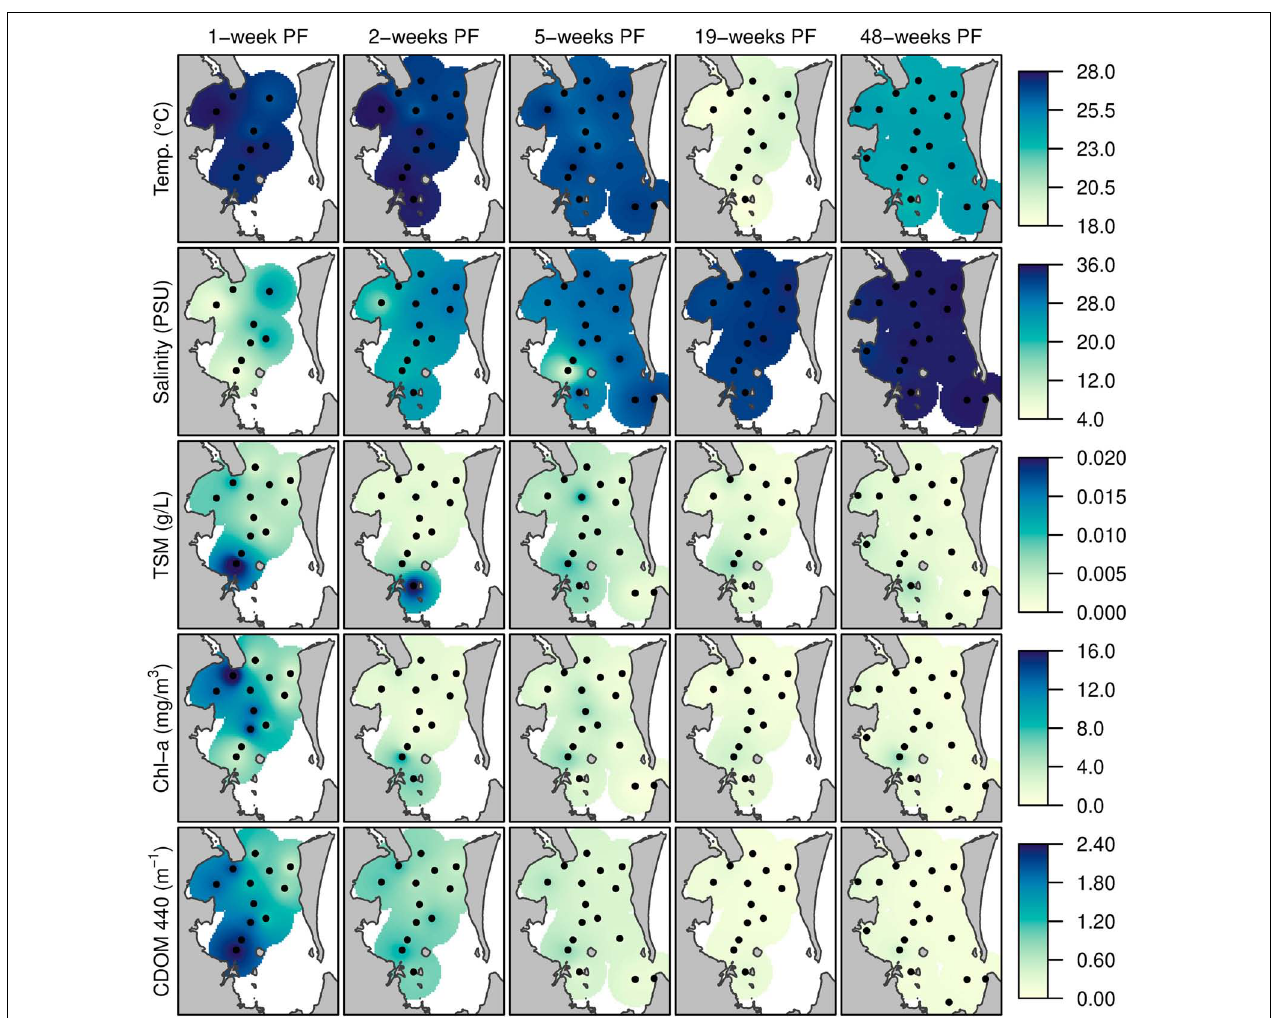
FIGURE 5 | Maps of temperature, salinity, TSM, Chl-a concentration, and CDOM absorption coefficient surface properties across Moreton Bay 1-, 2-, 5-, 19-, and 48-weeks post flood: Maps were produced with inverse distance weighted averaging using the R gstat package, ignoring coastline topography (Pebesma,